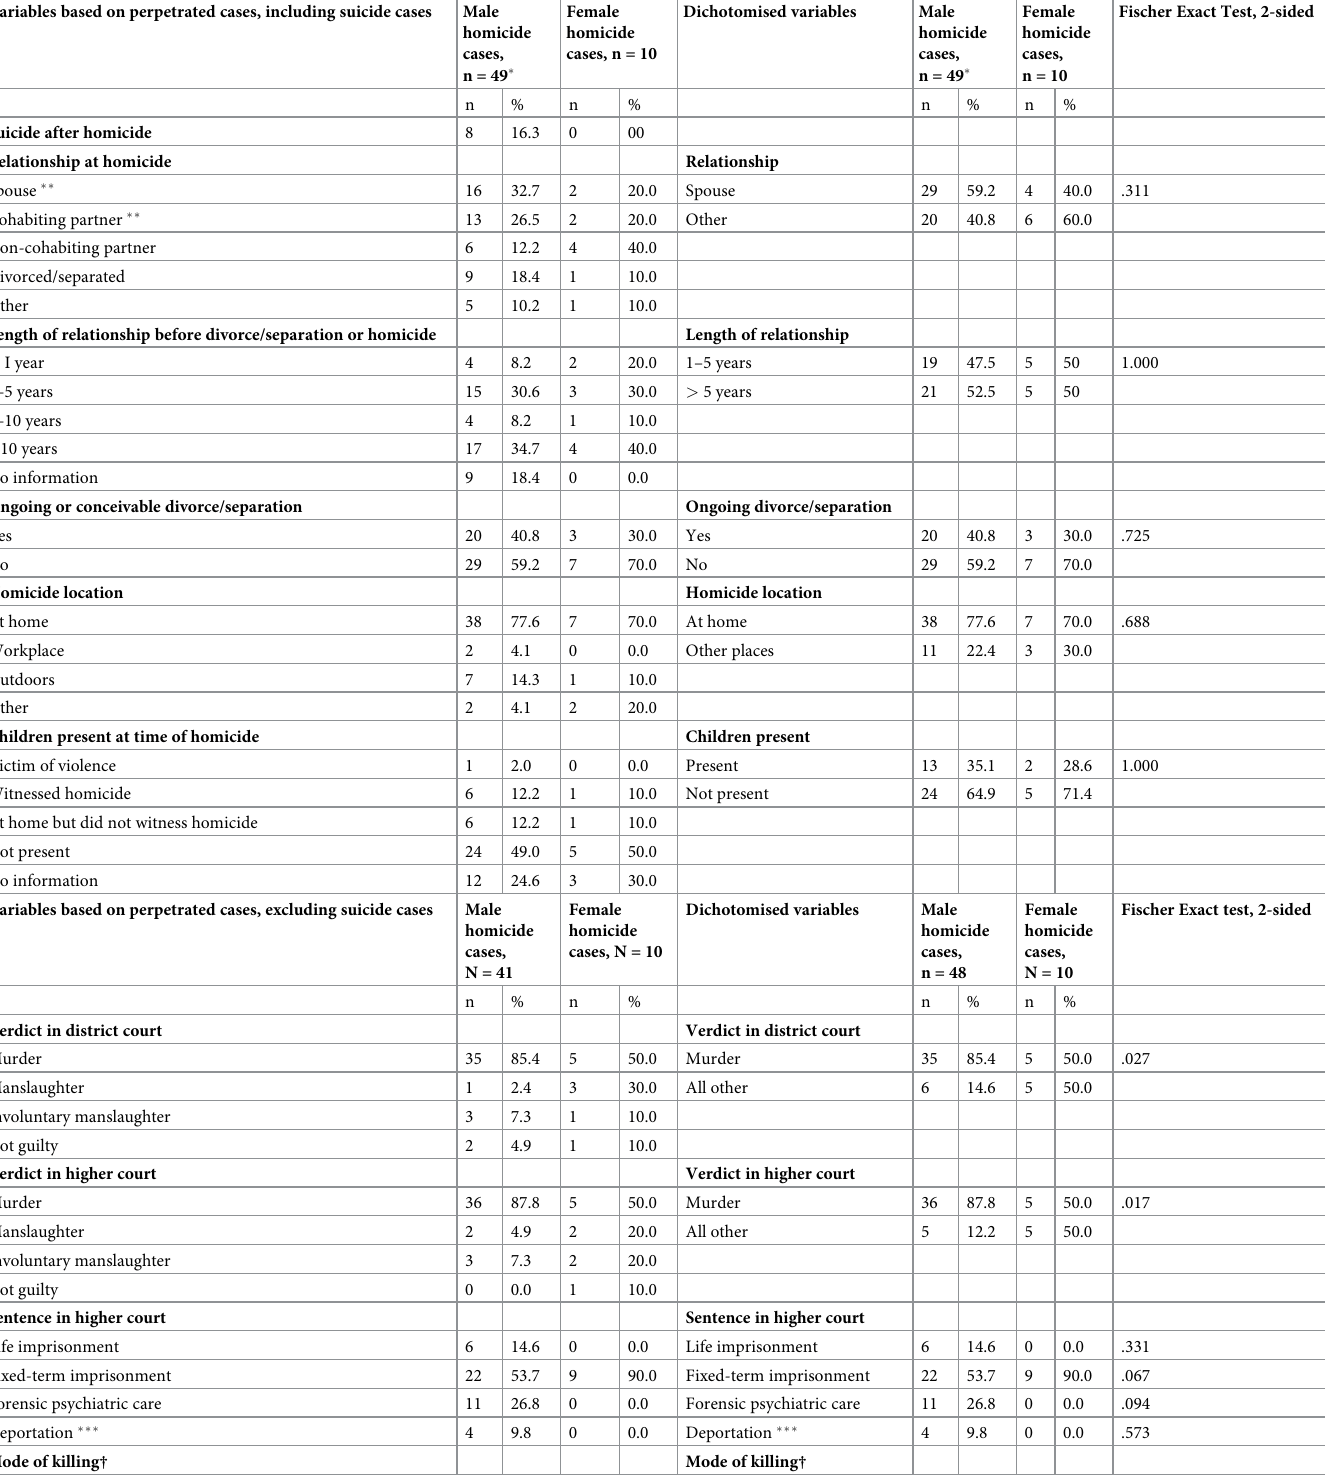
Table 1. Descriptive data related to IPH cases, numbers (n) and percentages (%), with Fisher’s exact test for male-perpetrated and female-perpetrated cases with dichotomised variables. N = 48 male and 10 female perpetrators, total of 59 cases � . Variables based on perpetrated cases, including suicide